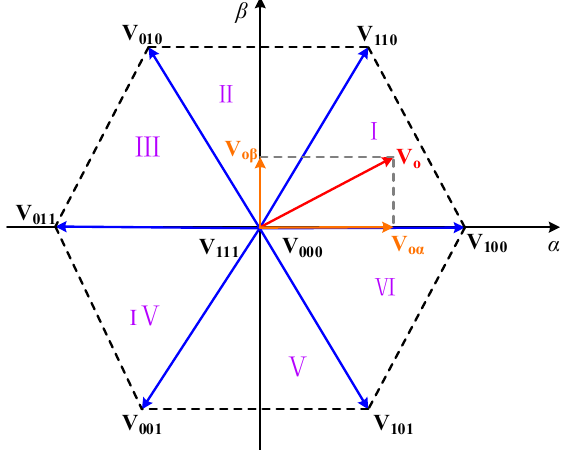
Figure 4. Space vector distribution for a six-switch three-phase converter.